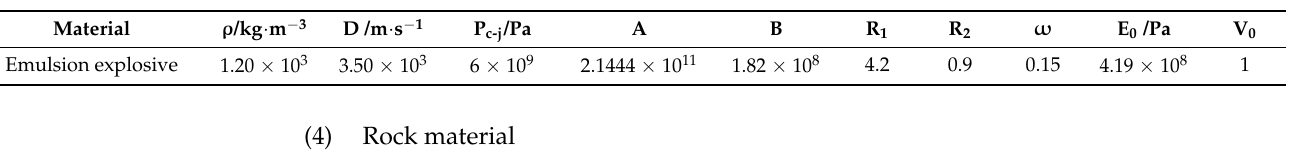
Table 8. Emulsion explosive performance parameters.